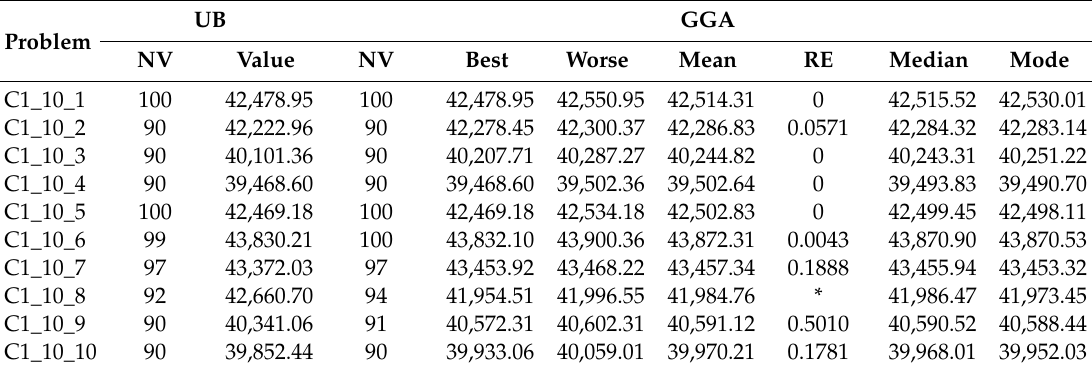
Table 5. Statistical results for 10 Gehring and Homberger benchmark